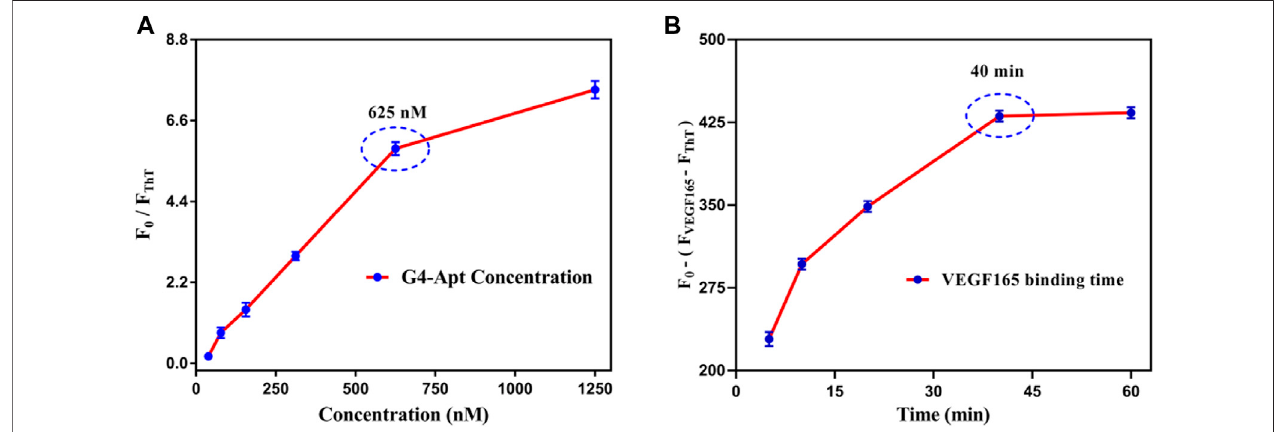
FIGURE 4 | (A) Optimization of the concentration for the assembled G4-Apt. (B) Optimization of binding time for VEGF165 in the detection